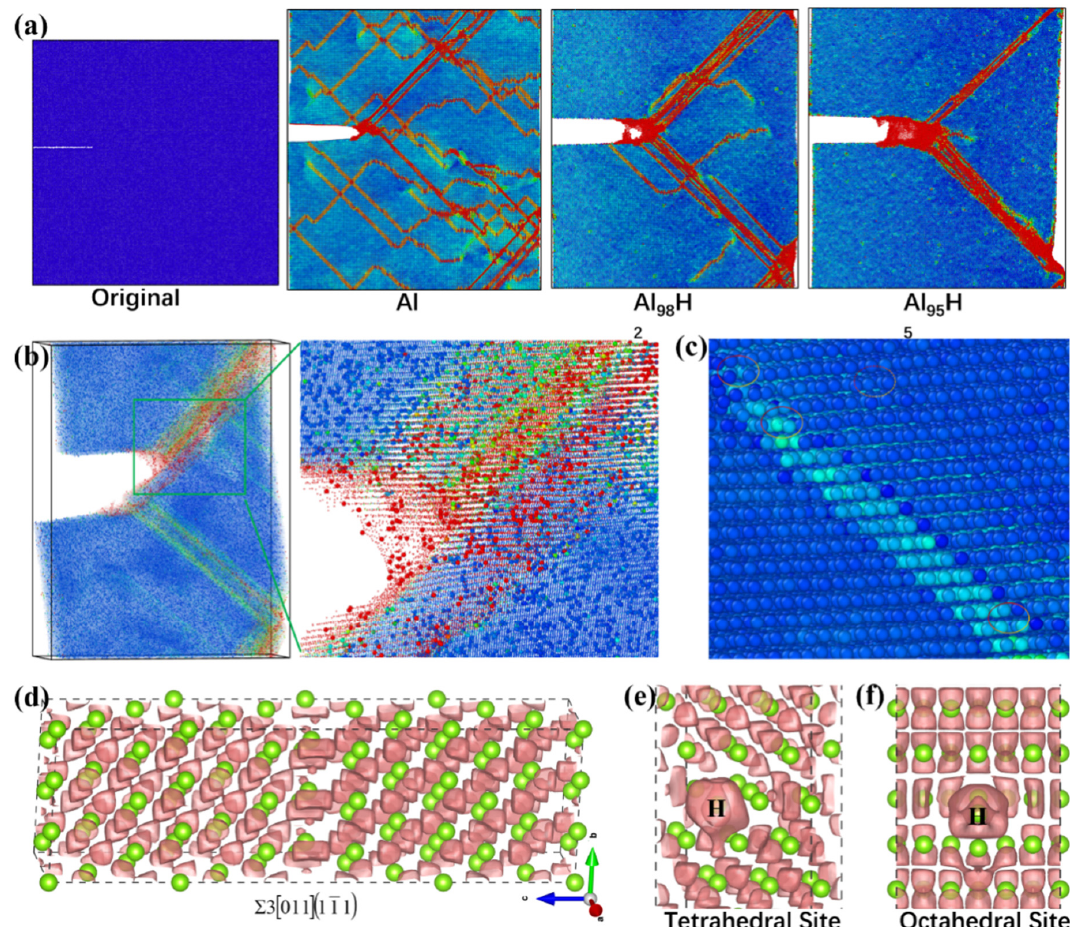
Figure 10. The atomic and electronic bases for the hydrogen-assisted cracking of Al [4,35]: ( a ) the effect of hydrogen on the deformation behavior and crack propagation of Al, Al 98 H 2 , and Al 95 H 5 under axial tension at a strain rate of 1 × 10 − 9 s − 1 ; ( b ) the trapped hydrogen-activated crack propagation and slip of Al 98 H 2 presenting a clear contrast by enlarging the atomic radii of H atoms relative to those of Al atoms; ( c ) the trapped hydrogen at the tip of the dislocation; ( d ) the bonding charge density of ∑ 3 [ 011 ] 111 GB of Al; ( e , f ) hydrogen embrittlement for the tetrahedral and octahedral occupations, respectively, at the ∑ 3 [ 011 ] 111 GB. The von Mises strain in ( a – c ) was utilized to present the blue–green–red (BGR) gradient colors, with minimum and maximum values of 0.001 and 0.9,